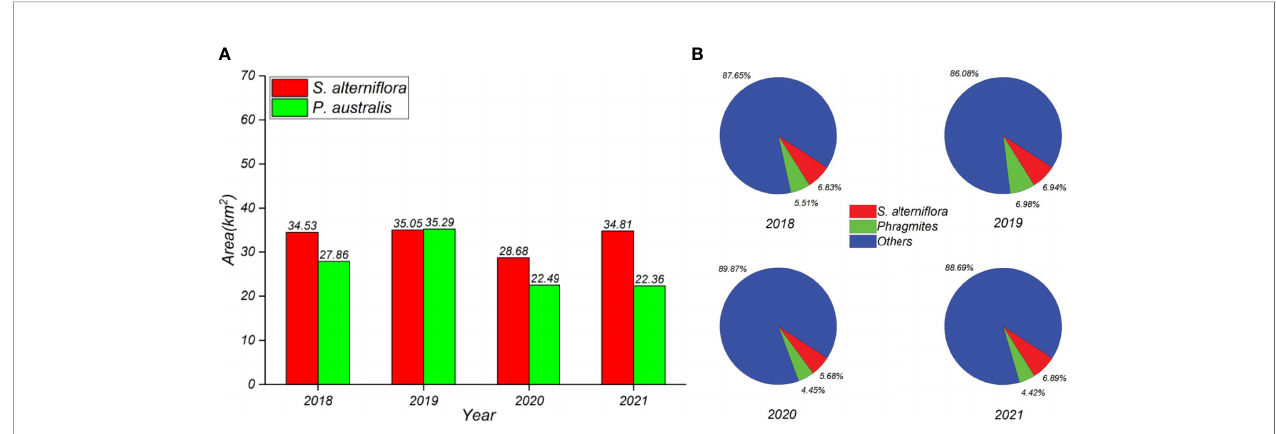
FIGURE 12 | Statistical graph of S. alterni fl ora and P. australis from 2018 to 2021. (A) is the area statistical graph; (B) is the proportion change